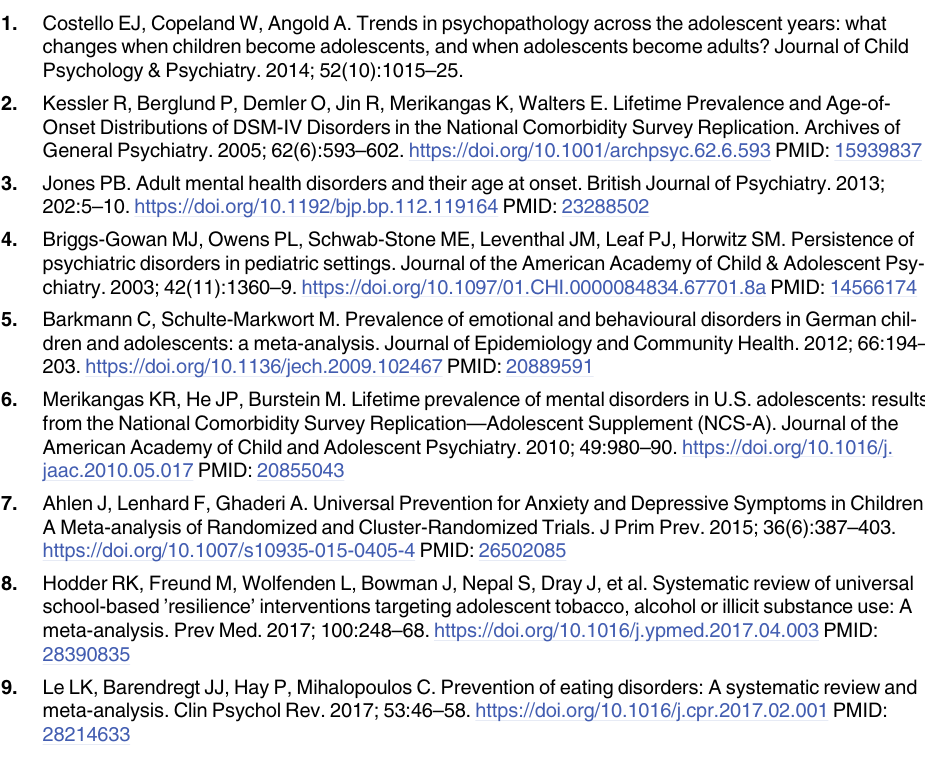
S2 Table. Risk of bias for studies included in the meta-analysis. S3 Table. a. Subgroup analysis at end of intervention for conduct and substance disorders. b. Subgroup analysis at end of intervention for depressive and anxiety disorders. S1 Fig. Random effects funnel plot for each diagnostic